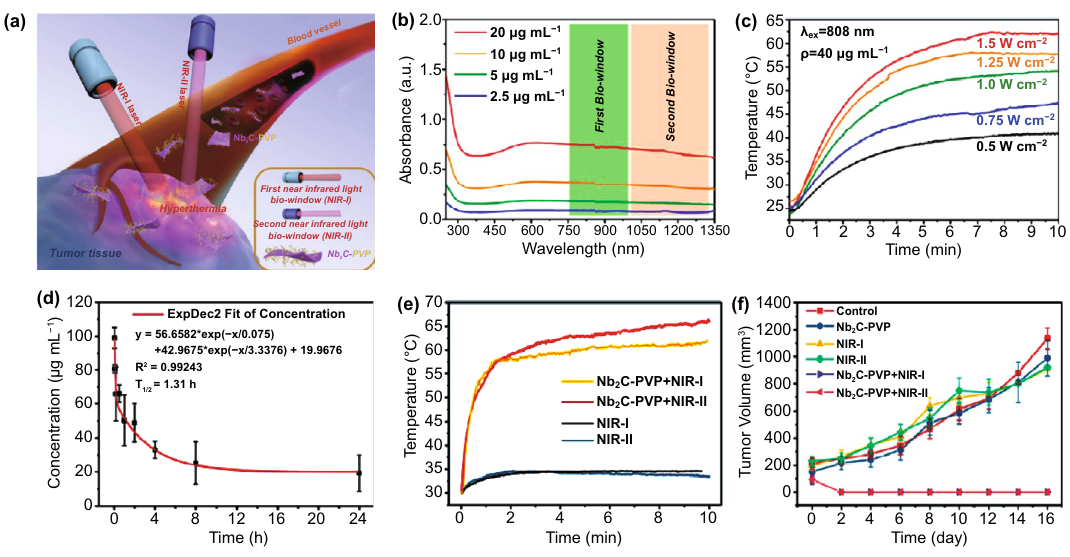
Fig. 12 Medical treatment based on Nb 2 C. a Schematic diagram of two-dimensional Nb 2 C used in photothermal treatment of tumors. b S-NIR absorption spectra of different concentrations of Nb 2 C NSs aqueous suspension. c Photothermal curve of Nb 2 C NSs aqueous suspension irradi- ated by 808 nm near-infrared light irradiation at different power densities. d Blood circulation lifetime of Nb 2 C − PVP after intravenous injec- tion into mice. e Temperature elevations at the tumor sites of 4T1-tumor-bearing mice in groups of NIR-I, NIR-II, Nb 2 C − PVP + NIR-I and Nb 2 C − PVP + NIR-II during laser irradiation. f Time-dependent tumor growth curves after different treatments (control, Nb 2 C − PVP only, NIR- I, NIR-II,